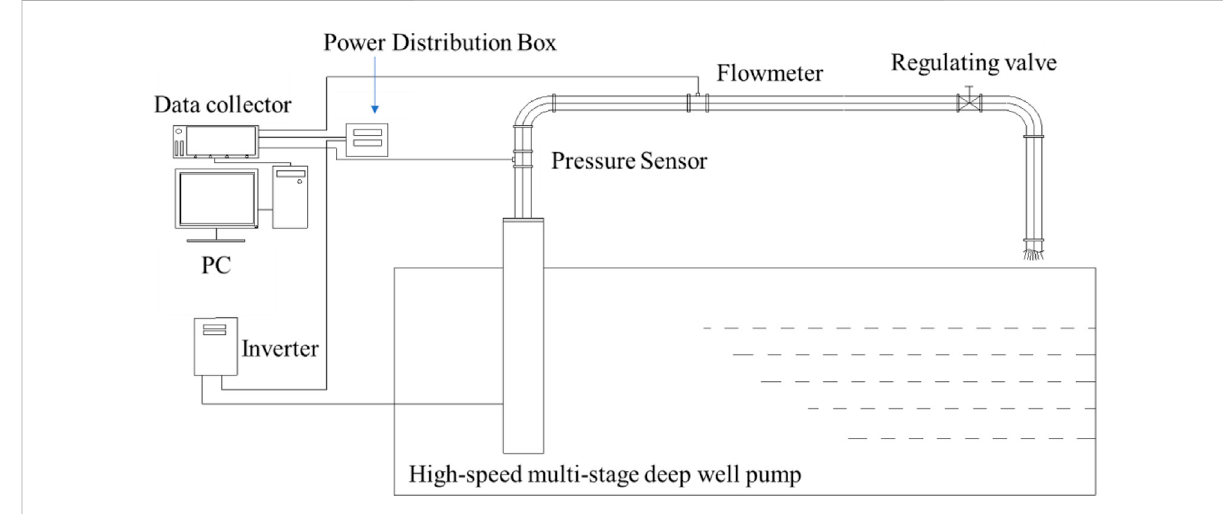
FIGURE 5 Schematic diagram of the experimental test device.